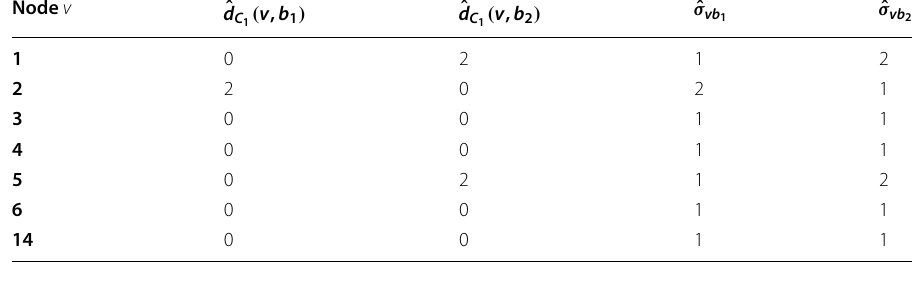
Table 2 Normalized distances and normalized number of shortest paths for the blue cluster C 1 Node v